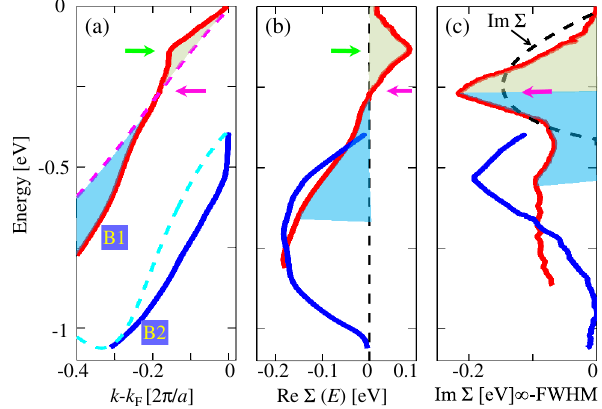
FIG. 2. The real and imaginary parts of the experimental self- energy. (a) Two low-lying dispersions derived from the peak positions of the MDCs [Fig. 1(d)] along M ! (cid:1) . The momentum axis is offset by k F for band B1. Dashed lines of same color give the ab-initio dispersion (offset from their corresponding Fermi- momenta values) which help expose the degree of anomaly for each dispersion with respect to their linear dispersion features. (b) The real part of the self-energy measures the deviation of each dispersion curve in panel (a) from its corresponding GGA value. The green arrow marks the location of the low-energy kink. (c) The inverse of the MDCs width obtained with the help of Fig. 1(c), which is proportional to the imaginary part of the self-energy, when the extrinsic background contribution is neg- ligible. Different color fillings in all three curves (corresponding to band B1) separate the characteristic energy scale (marked by red arrows). The imaginary part attains a peak at the energy where the real part of the self-energy changes sign. To demon- strate this behavior we calculate Im(cid:2) from Re(cid:2) in panel (b) and plot it as a black dashed line in panel